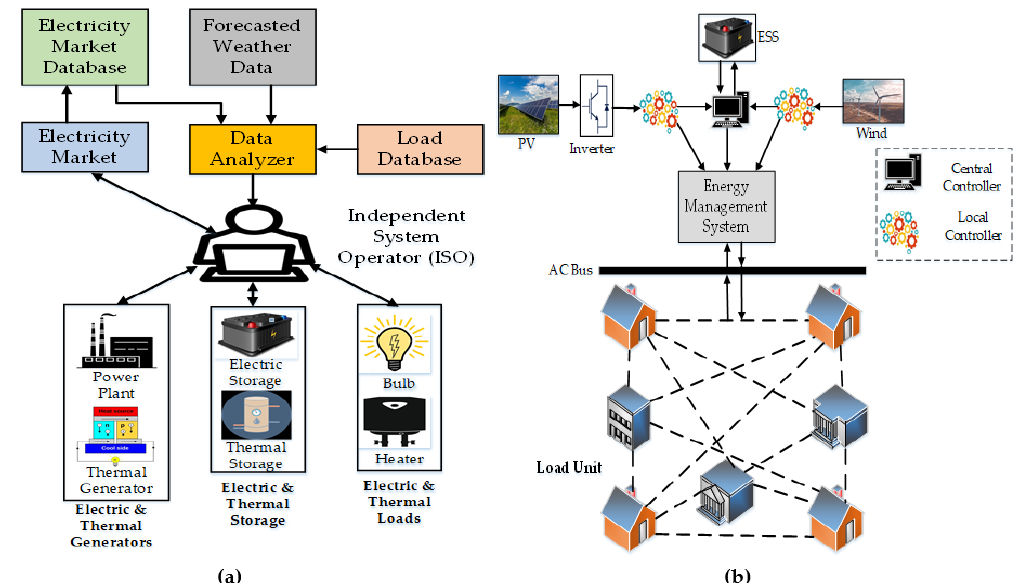
Figure 8. A schematic representation of the virtual power plant for ( a ) a probabilistic method (Redrawn with permission from [47], 2016, Elsevier); ( b ) Generation driver control strategy. (Note: PV-photovoltaics; AC-alternating current; ESS-energy storage system).